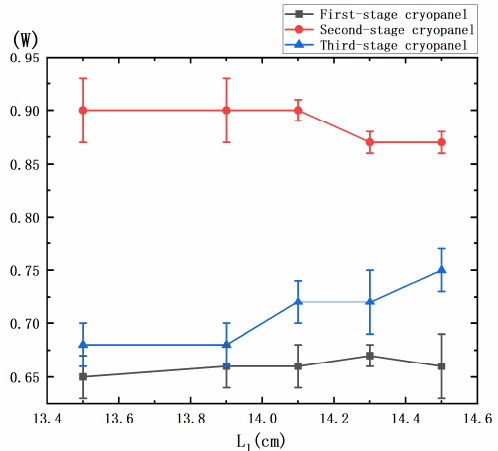
Figure 21. The absorbed radiation of three-stage cryopanels versus L 1 . On analyzing the influence of L 2 = 13.3–14.7 cm and L 3 = 11.1–12.1 cm on the absorbed L 3 had no influence here.